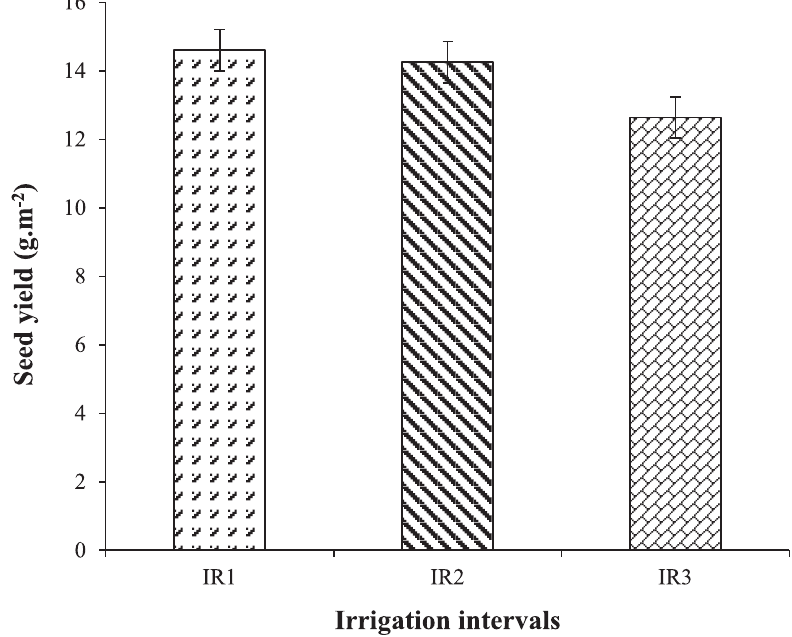
Figure 1 - Effect of irrigation intervals on seed yield of oregano. Vertical bars indicate standard